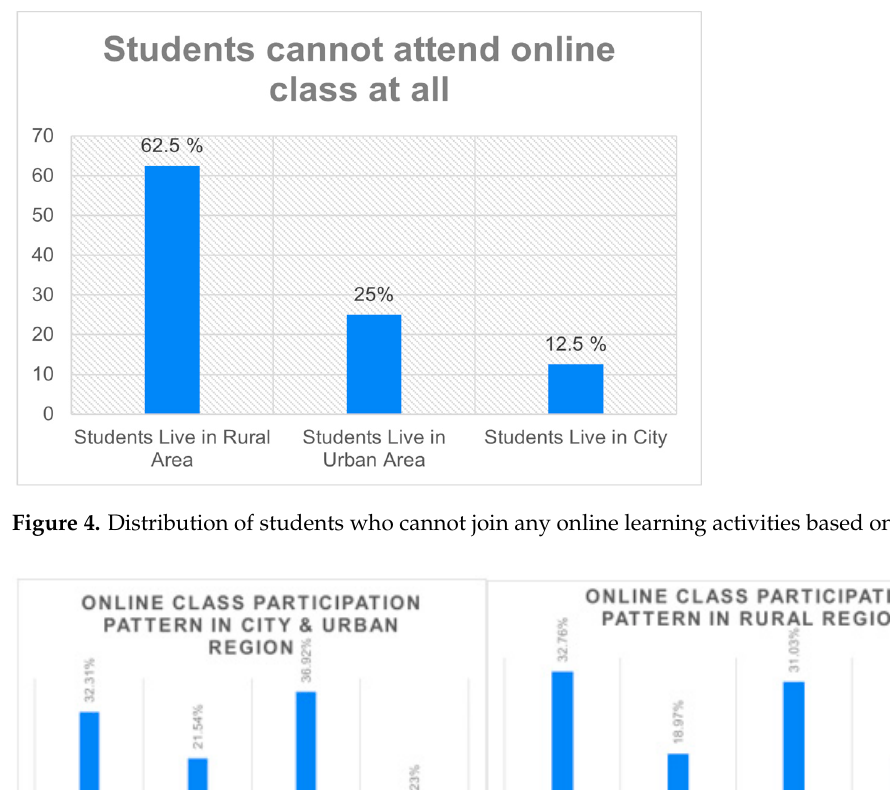
Figure 5. Participation pattern in online classes based in a different location.